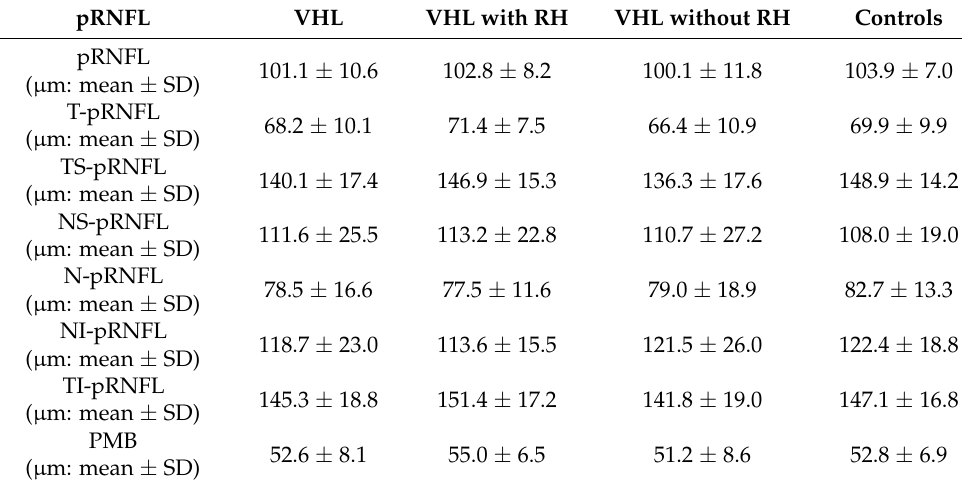
Table 2. pRNFL thickness in the analyzed groups.